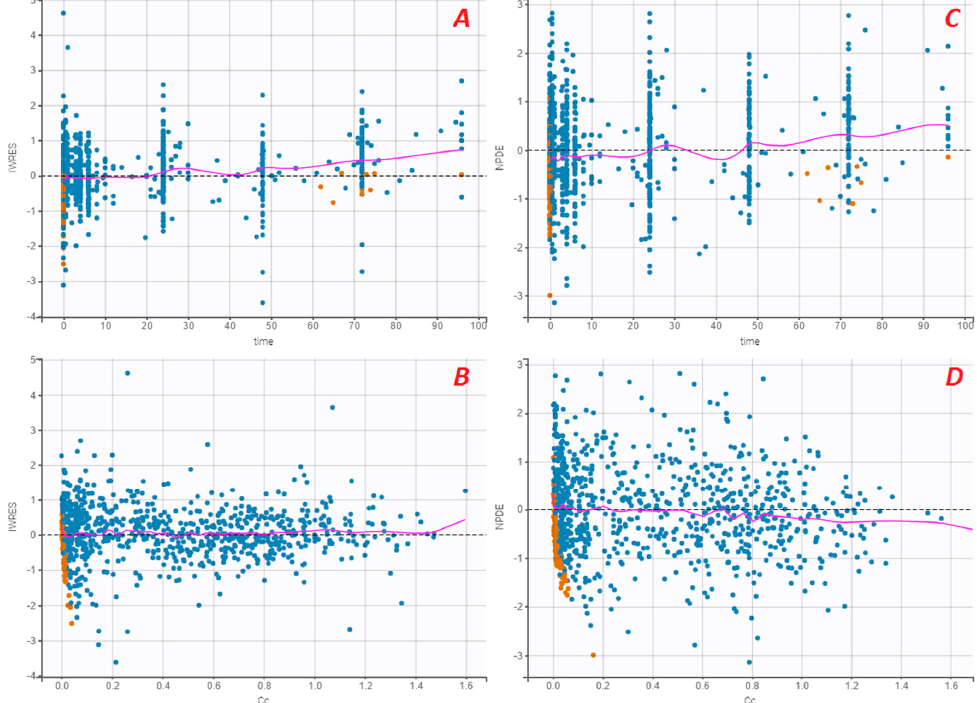
Figure 2. Individual weighted residual (IWRES) versus time ( A ) and individual predictions after dose ( B ). Normalised prediction errors (NPDE) versus time ( C ) and population predictions after dose ( D ). Abbreviations: Cc, FVIII:C (IU/mL); time in hour. Blue dots are observed FVIII:C; orange dots are observed FVIII:C BLQ; the purple solid line is the spline.